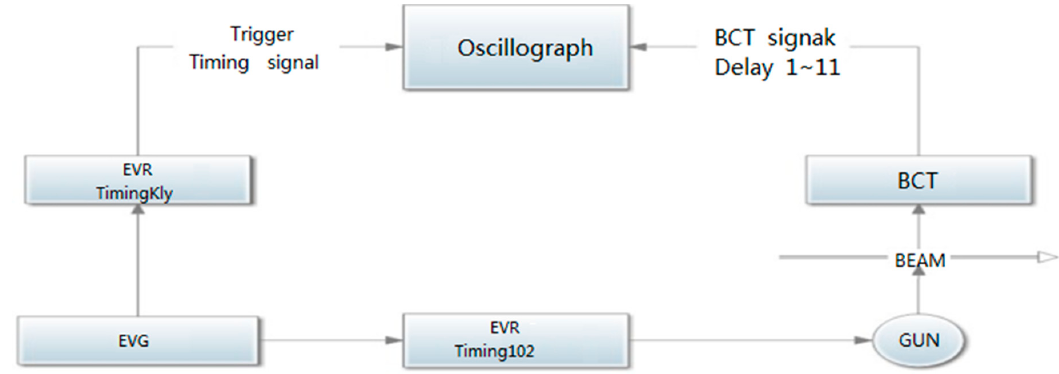
Figure 2. Beam current and timing measurement scheme in the